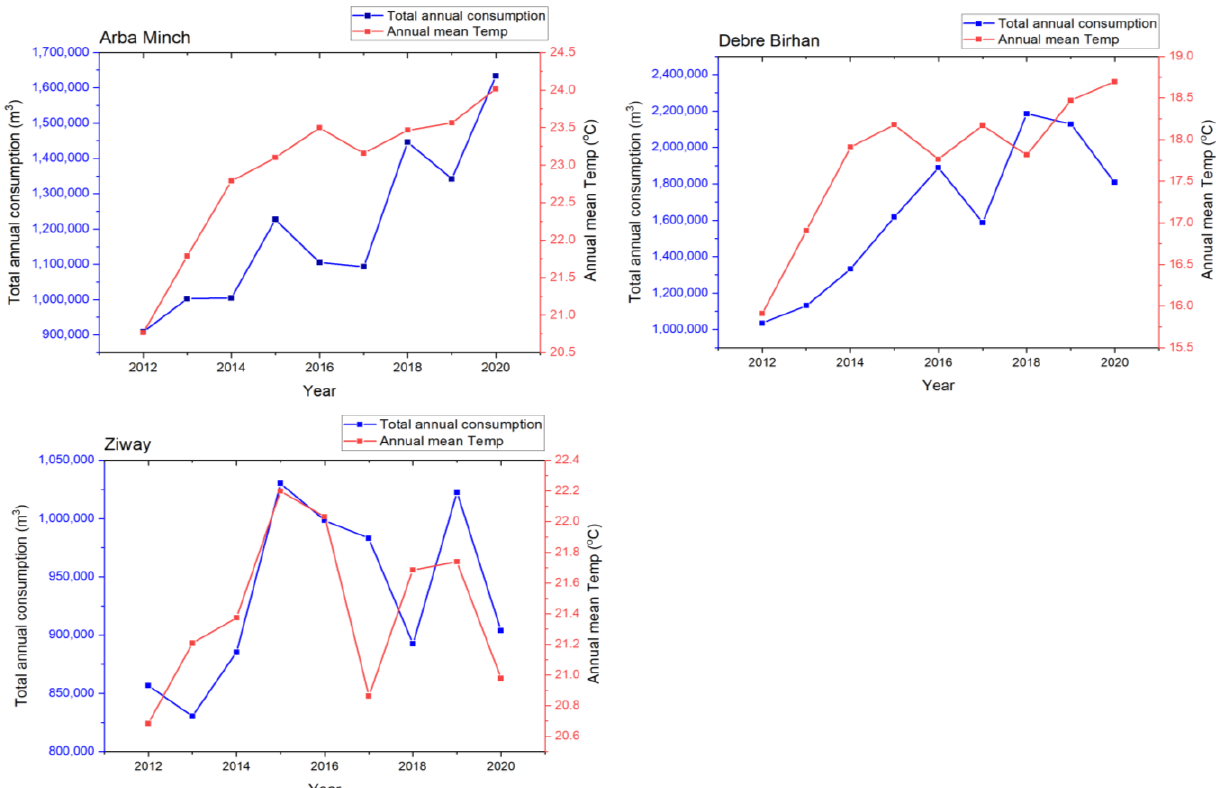
Figure 4. Total annual water consumption vs. annual mean temperature of the study